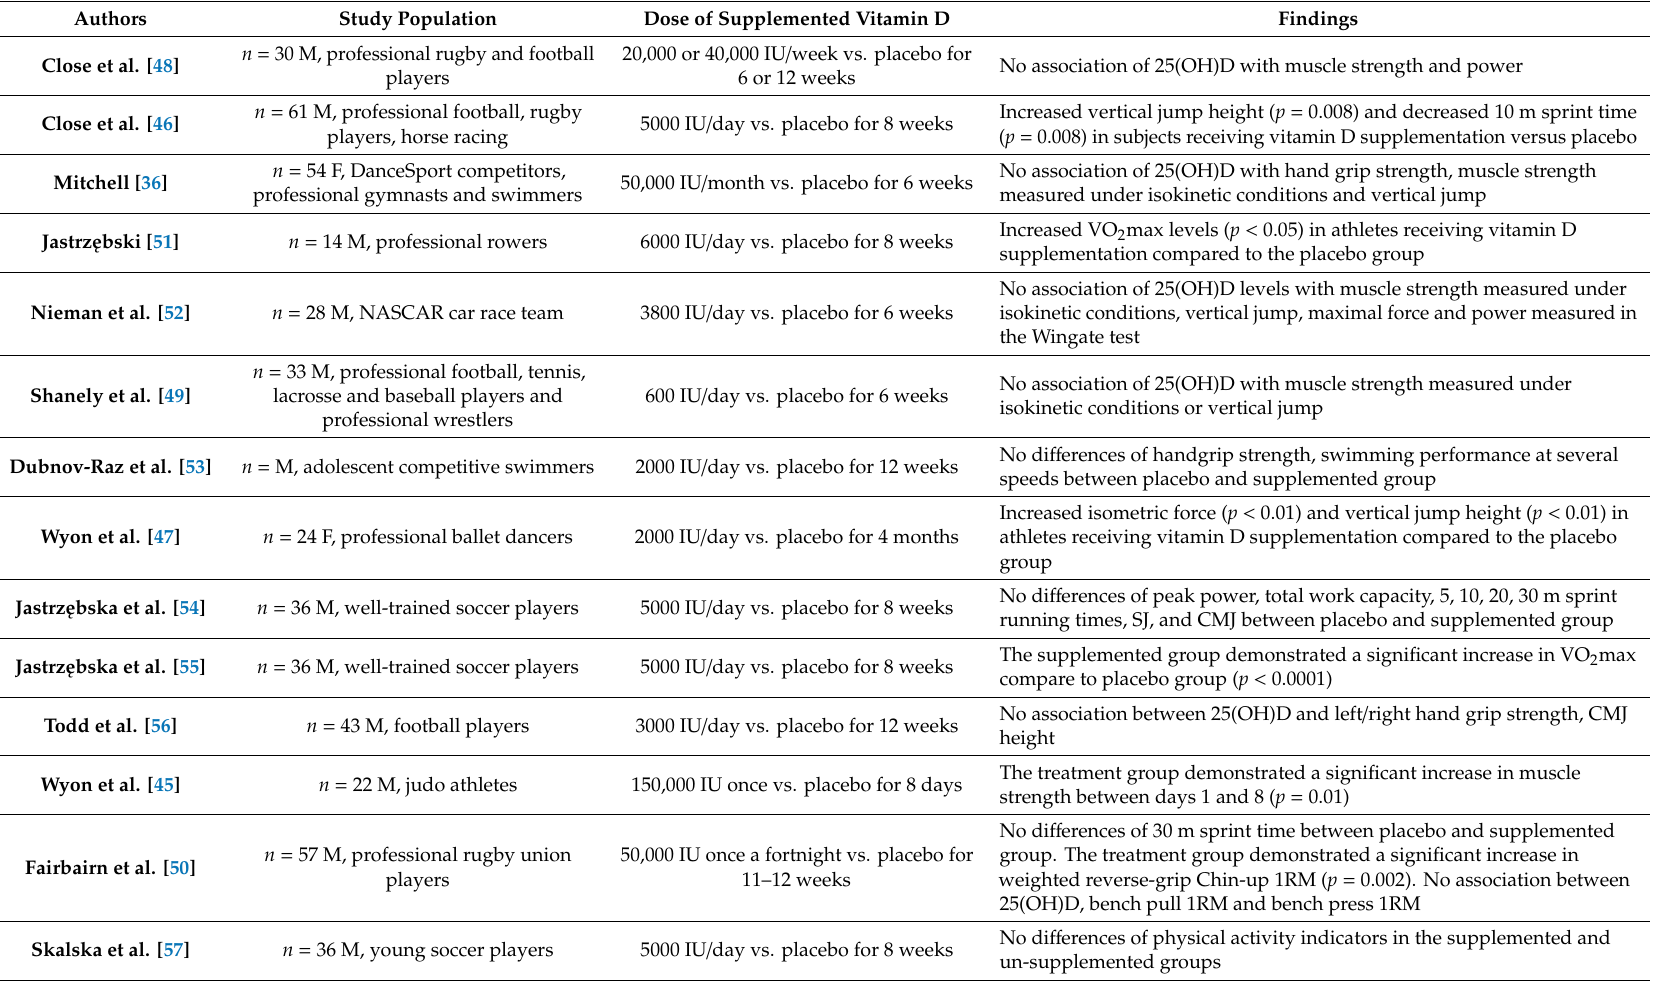
Table 2. E ff ects of vitamin D supplementation on athletic performance and VO 2 max in